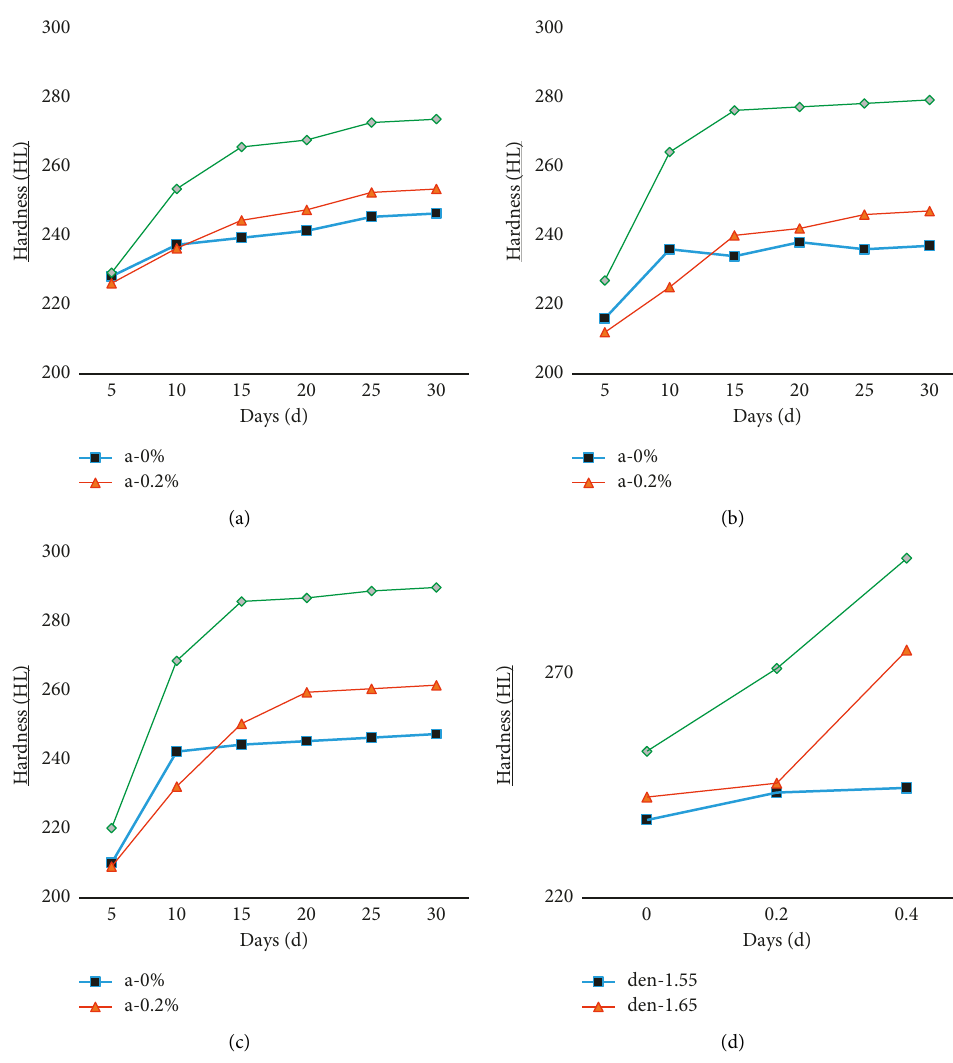
Figure 3: Variation curve of sample hardness with age. Table 2: Compressive strength at different ages. Density (g · cm 3 ) a-solid content